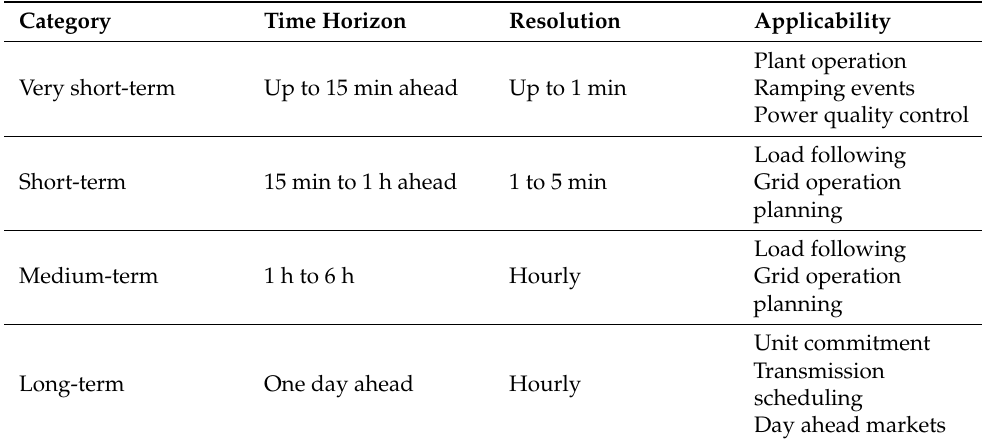
Table 1. Forecast horizon categories, granularity and applications.